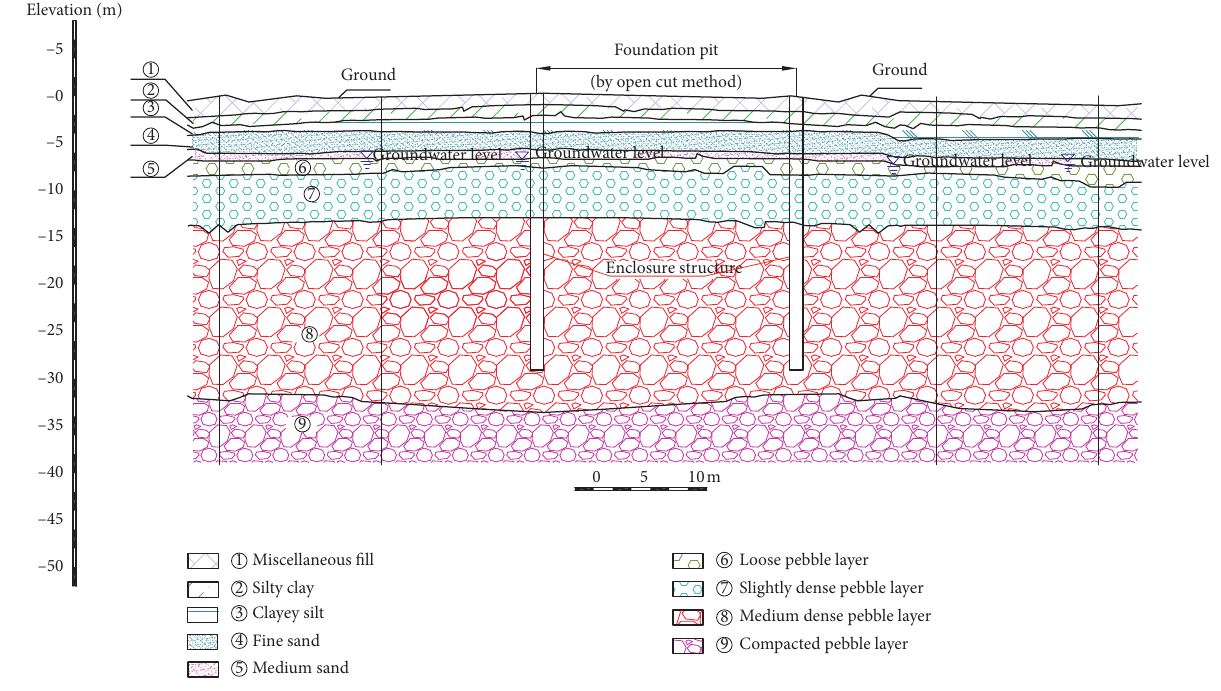
Figure 11: Geological section of the